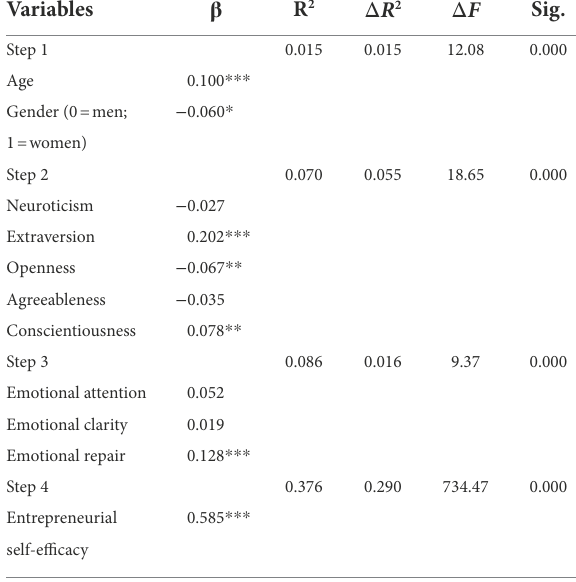
TABLE 3 Results of hierarchical regression analysis for age, gender, personality, and emotional intelligence predicting entrepreneurial intention mediated by